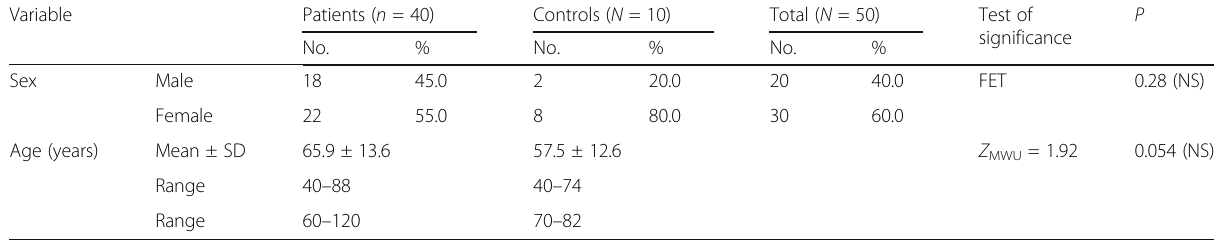
Table 1 Demographic characters of the studied sample descriptive data